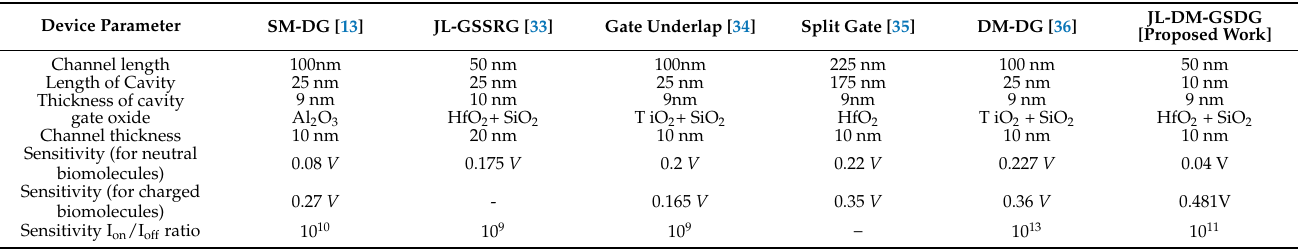
Table 4. Comparison of sensitivity metric of JL-DM-GSDG-MOSFET biosensor with the